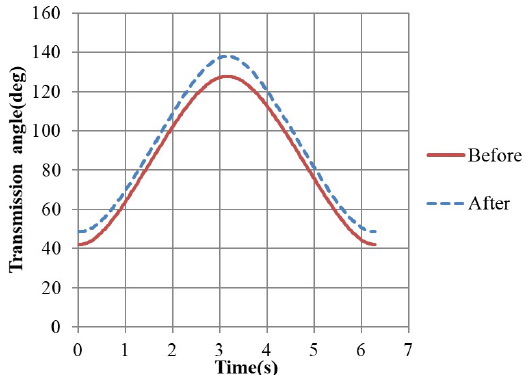
Figure 18. The transmission angle µ 4 of the driver side output-link of CDLS before/after DE optimization.